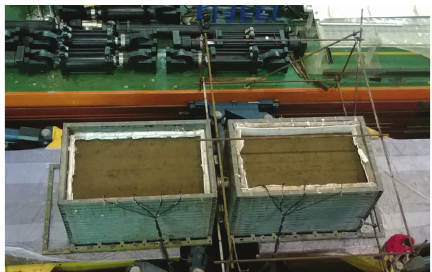
Figure 2: Shaking table test of site under nonuniform seismic excitation.